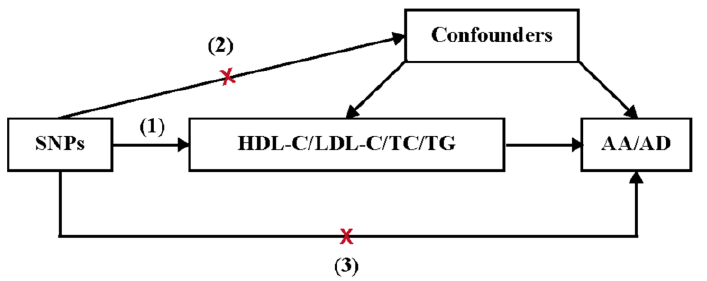
Figure 1. Three key assumptions of the MR study. (1) SNPs are robustly associated with plasma LDL-C, TC, TG, or HDL-C; (2) SNPs are independent of other known confounders; (3) SNPs affect the risk of AA or AD only through plasma LDL-C, TC, TG, or HDL-C. The red X means that the SNPs selected as the instrumental variables are not associated with the confounders and the outcomes